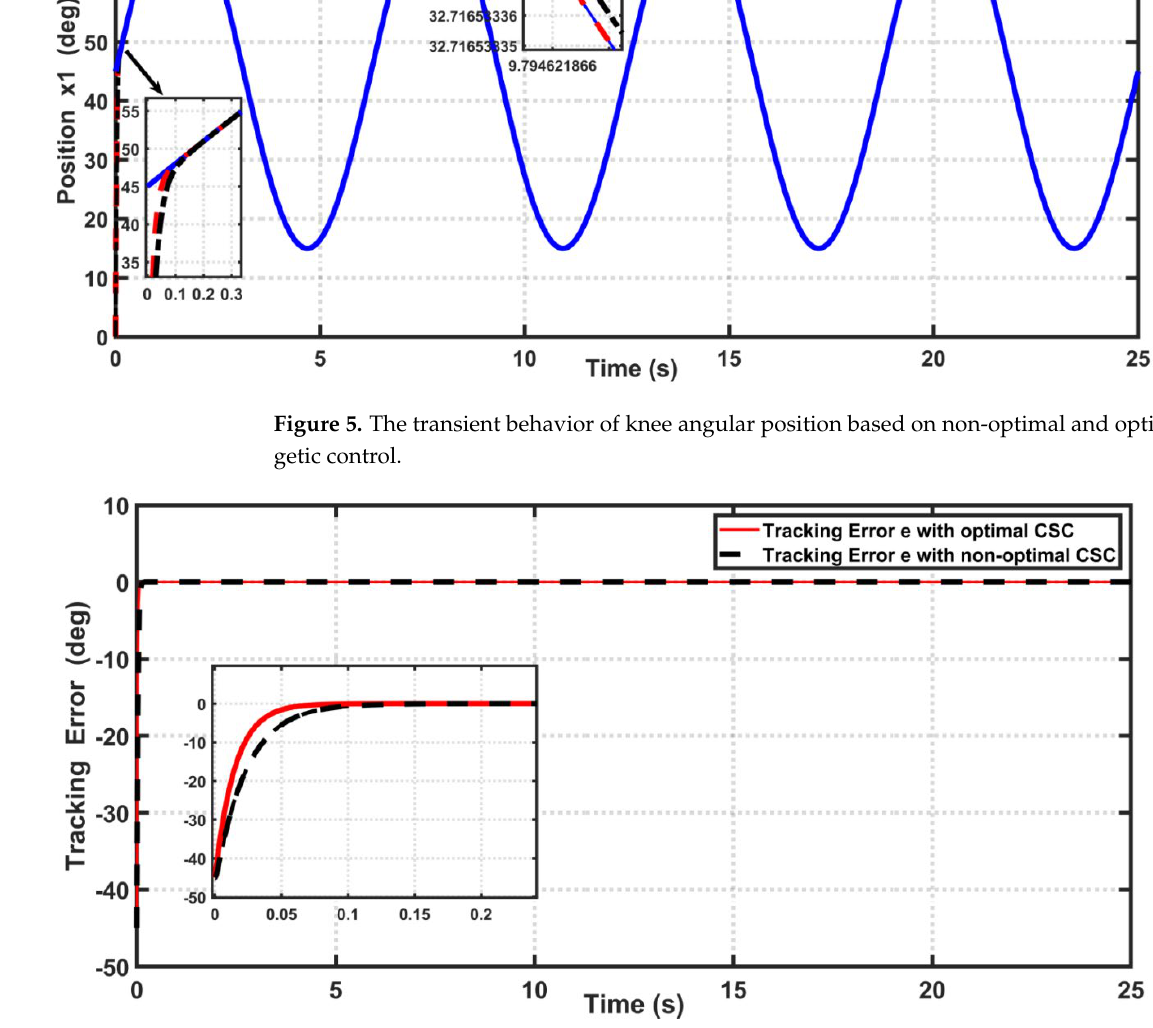
Figure 6. Behaviors of tracking errors for both non-optimal and optimal synergetic control. The angular position velocities based on both versions of adaptive synergetic